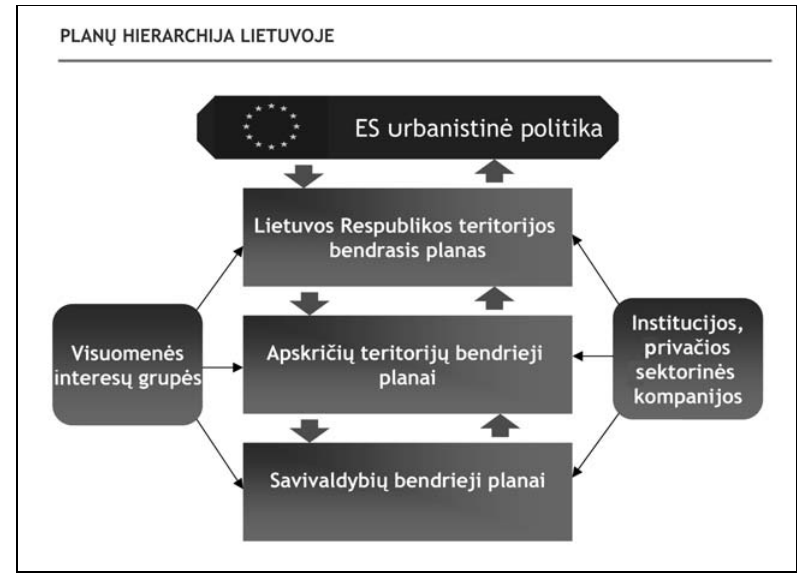
Fig 1. Hierarchy of Lithuanian strategic territory planning documents and